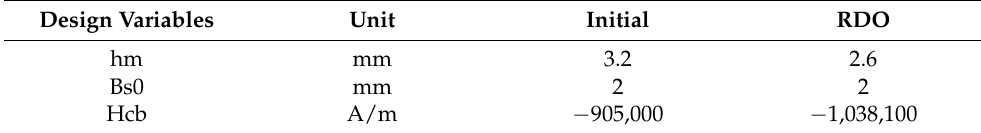
Table 5. Initial and robust optimal design of the PMSM.